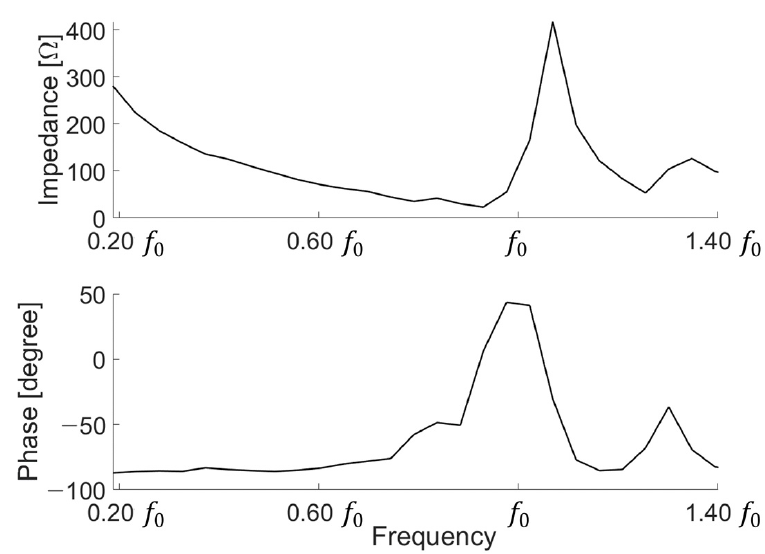
Figure 7. Measurement of electrical impedance.